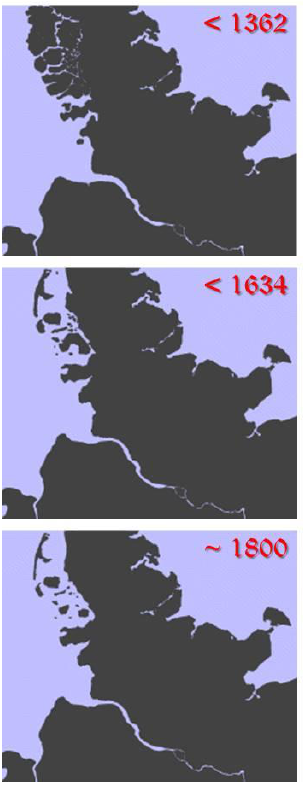
Figure 1. Changes in the German North Sea coastline during the past 700 years, after Behre